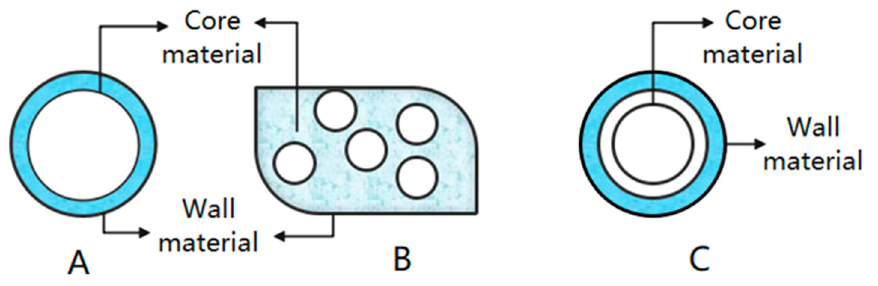
Figure 3. Several common types of microencapsulation. ( A ): single capsule; ( B ): microcapsule polymer; ( C ): multiple encapsulation.